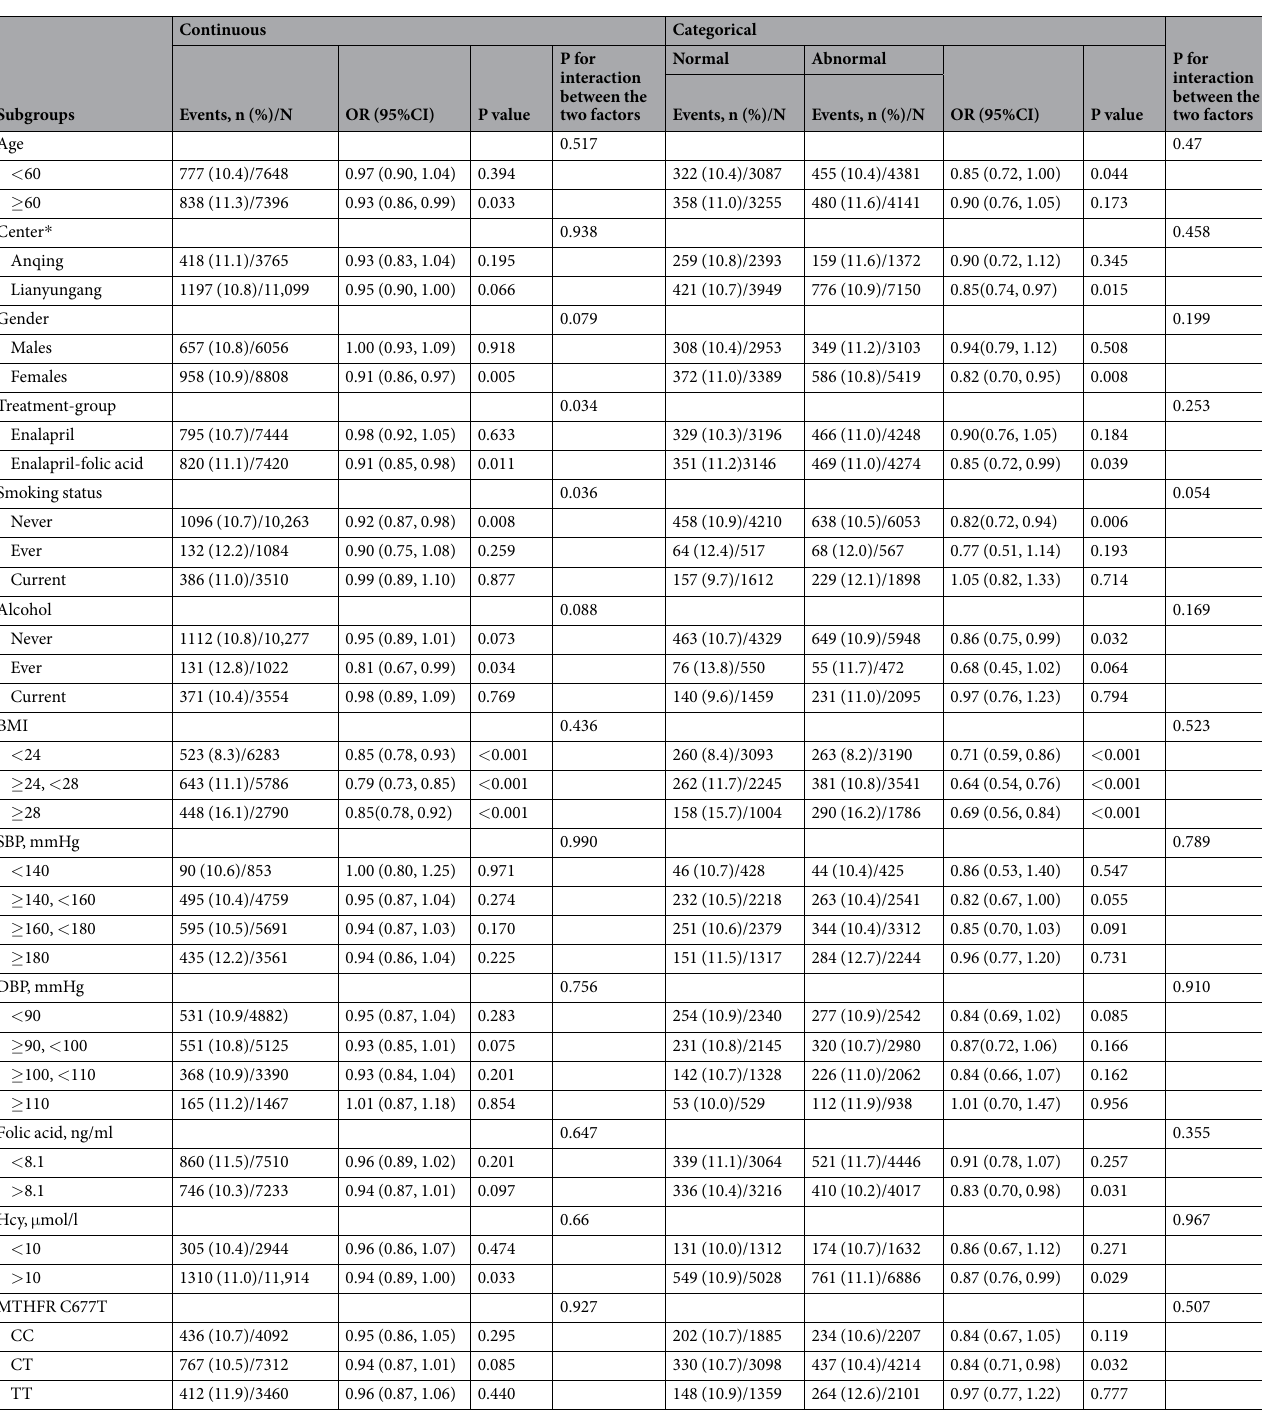
Table 4. Subgroup analysis of NOD risk associated with TC according to important covariates by logistic regression. SBP = systolic blood pressure, DBP = diastolic blood pressure, TG = triglycerides, HDL = high-density lipoprotein, TC = total cholesterol, HCY = homocysteine, NOD = new-onset diabetes. MTHFR = methylenetetrahydrofolate reductase. * Clinical center represents two rural areas in Anhui and Jiangsu provinces in China. Adjusted for age, gender, clinical center, SBP, DBP, smoking and drinking status, baseline FPG, and BMI, if not stratified. Only TG levels were analyzed because of colinearity with TC and